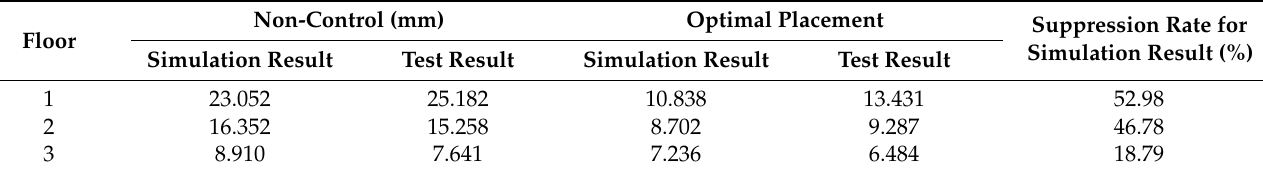
Table 6. Peak storey drift and corresponding suppression rates under optimal and uncontrolled conditions.